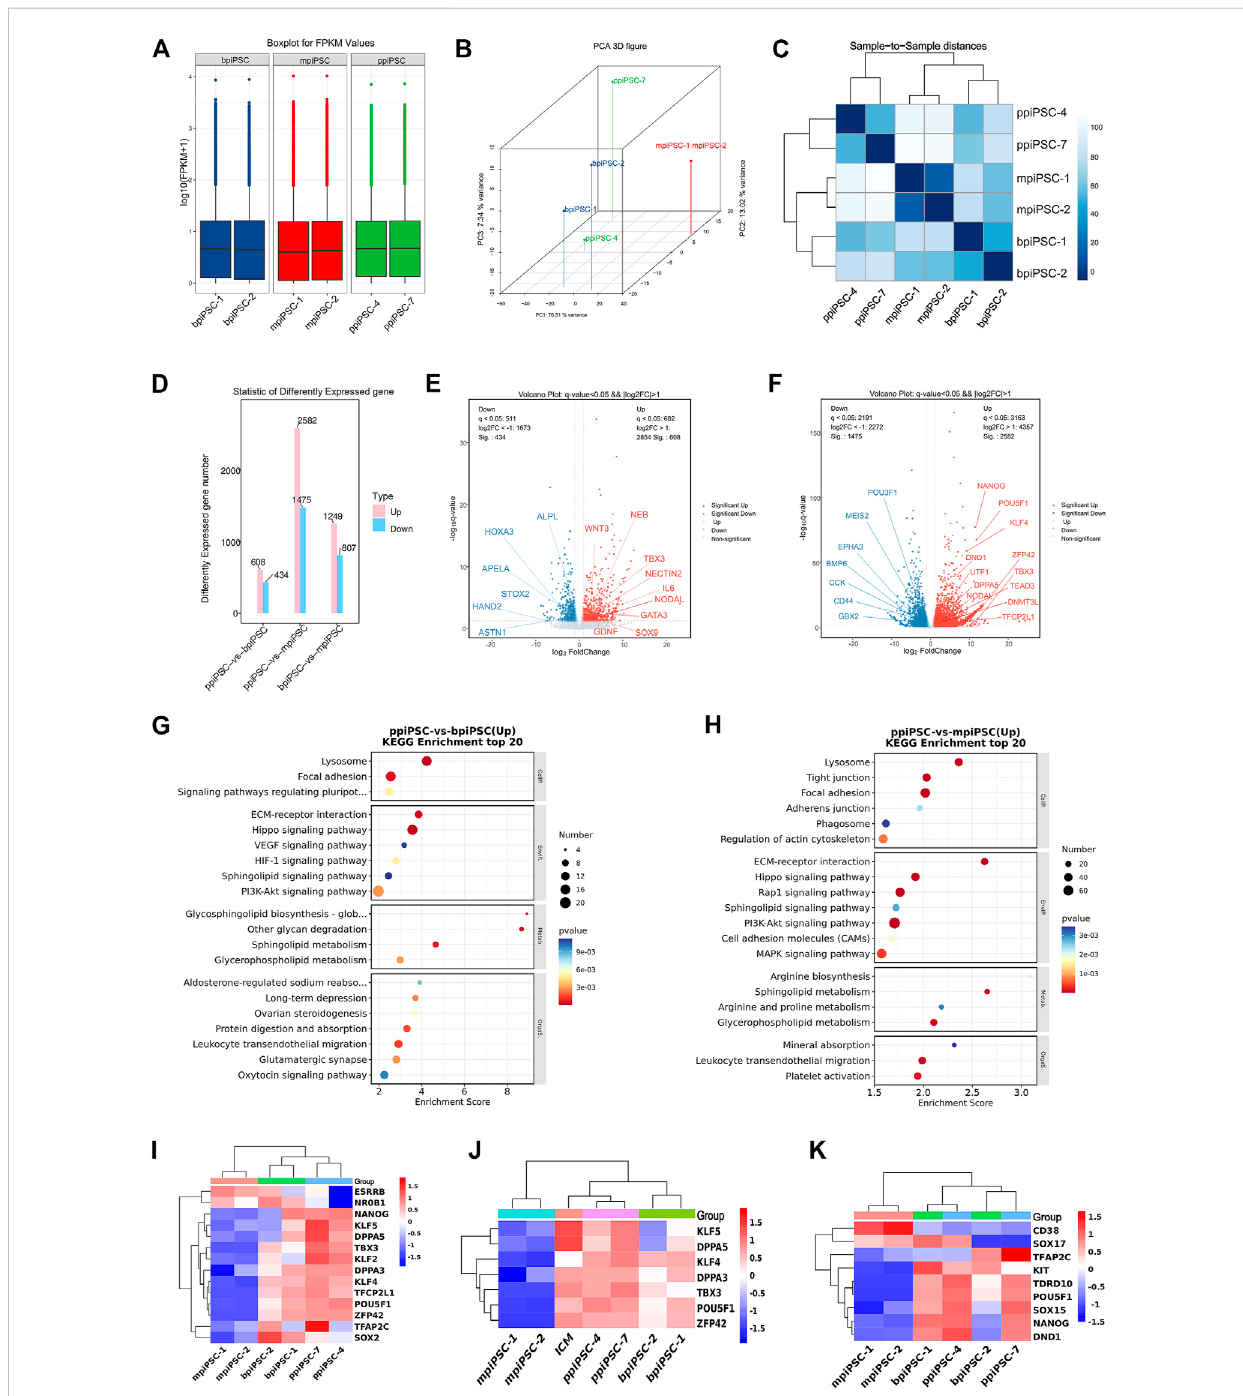
FIGURE 5 RNA-seq analysis of ppiPSCs, bpiPSCs and mpiPSCs. (A) Gene expression differences among mpiPSCs, bpiPSCs and ppiPSCs. (B) Global gene expression pro fi ling of mpiPSCs, bpiPSCs and ppiPSCs. (C) Pearson correlation analysis of different kinds of cells. (D – F) Statistic and comparation of different expressed genes of mpiPSCs, bpiPSCs and ppiPSCs. (G – H) KEGG enrichment analysis of ppiPSCs and bpiPSCs and ppiPSCs and mpiPSCs. (I) Expression heatmap of endogenous pluripotency markers in mpiPSCs, bpiPSCs and ppiPSCs. (J) Expression heatmap of pluripotency genes for piPSCs compared with porcine ICM. (K) Expression heatmap of the PGC early related genes in mpiPSCs, bpiPSCs and